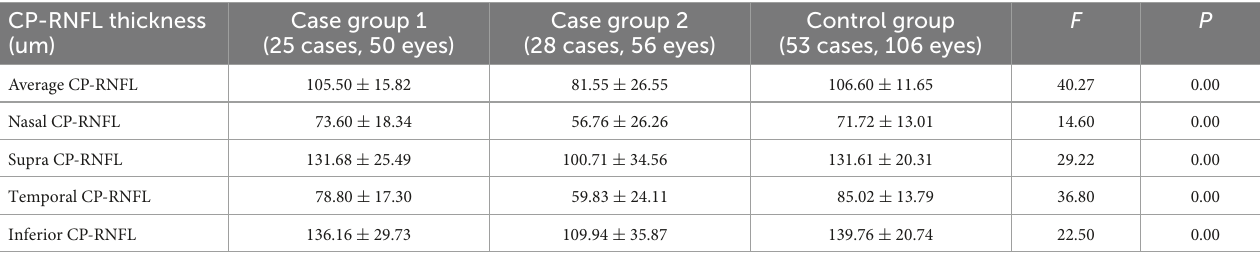
TABLE 3 Comparison of the thickness of GCC, IPL, and GCL between two case groups and control group. Macular GCC, IPL, and GCL thickness (um)